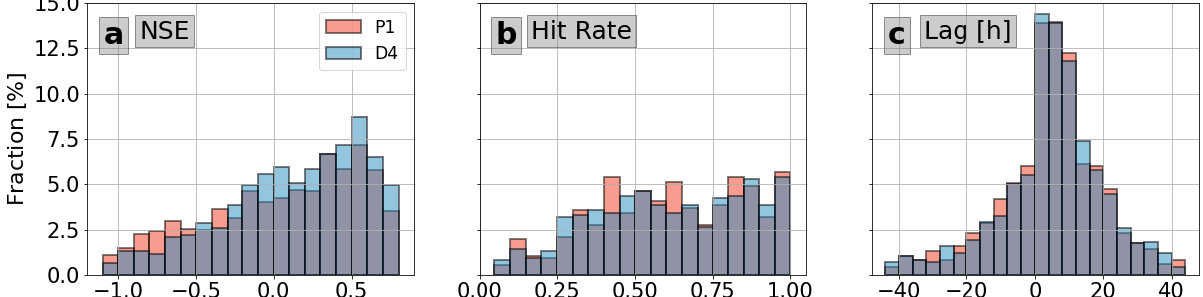
Figure 11. Histograms of performance metrics for the scenarios D4 and P1. Panel a compares the NSE. Panel ( b ) compares the Hit Rate considering ( a ) Hit when the simulated and observed streamflow are above the flood level of the gauge. Panel ( c ) compares the Lags (in hours) required to maximize the correlation between observations and simulations.